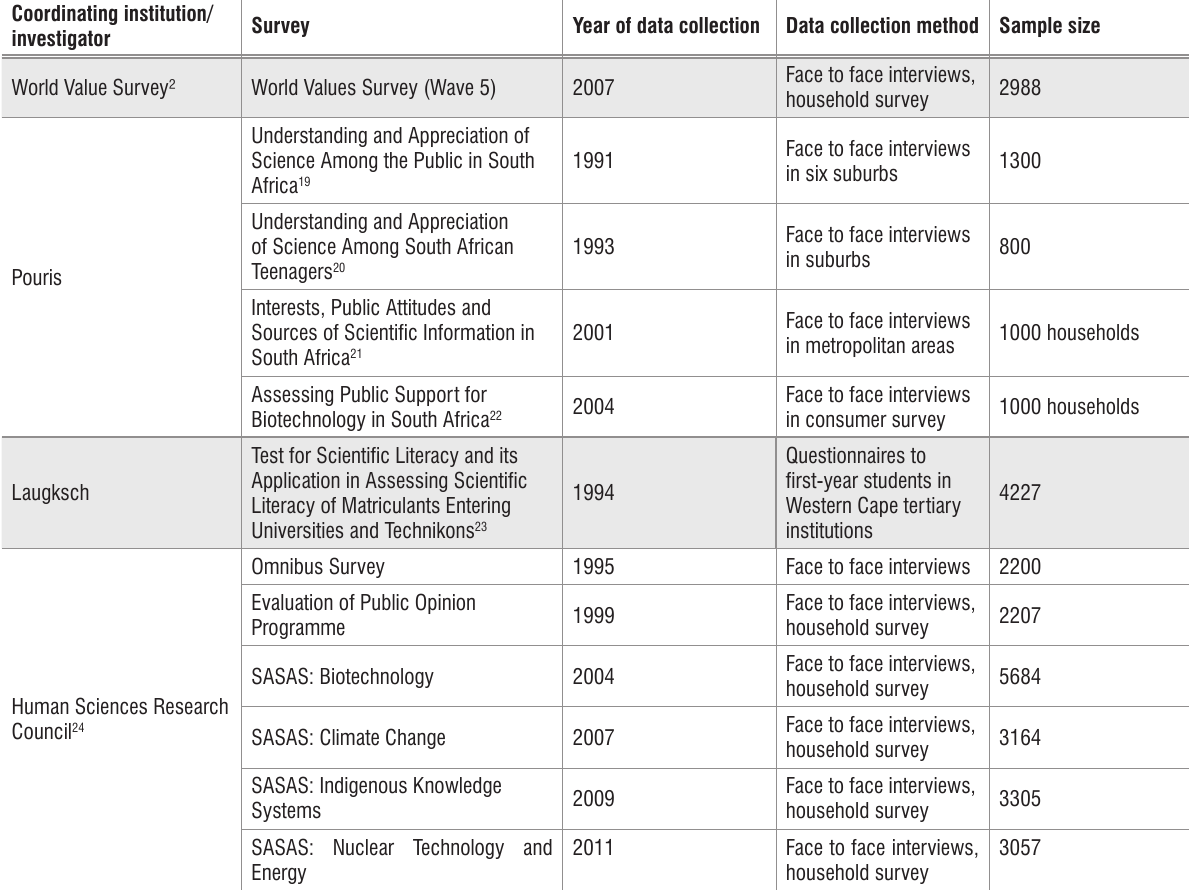
South African surveys that have included items related to the public’s relationship with science Coordinating institution/ investigator